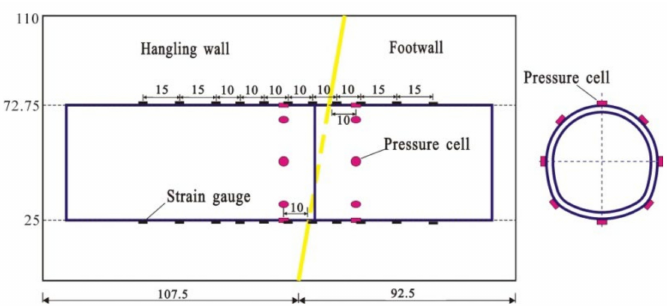
Figure 7. Layout of pressure cells and strain gauges on the subway tunnel (unit: